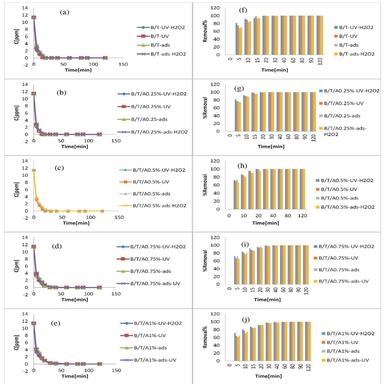
Dye removal kinetic results for MB by hydrogen peroxide-assisted photocatalytic degradation, UV photocatalytic degradation, catalytic hydrogen peroxide oxidation, and adsorption processes, respectively (10 mg/L concentration, 0.03 g nanocomposite, 120 min).